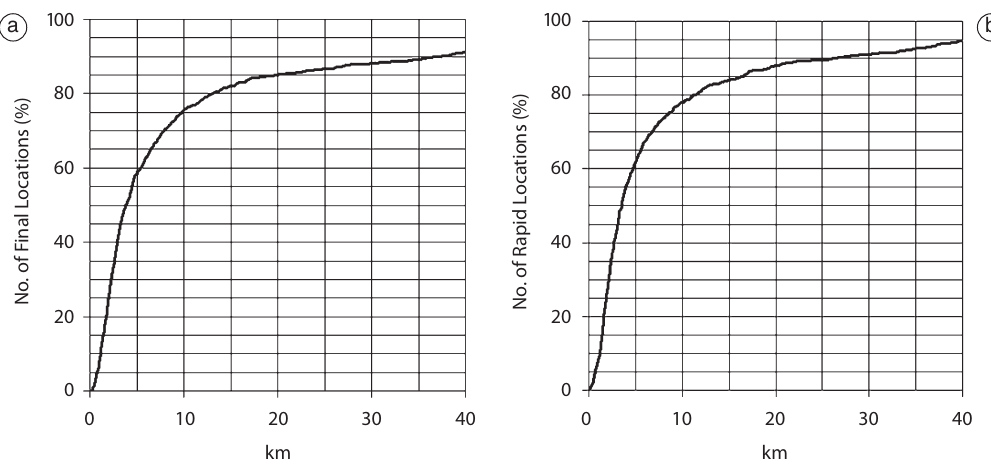
Fig. 7a,b. Cumulative distribution of the horizontal distances between the automatic locations and the Bulletin ones (year 2006, ML ≥ 2.5): a) final automatic vs. bulletin solutions; b) rapid (~40seconds) vs. bulletin